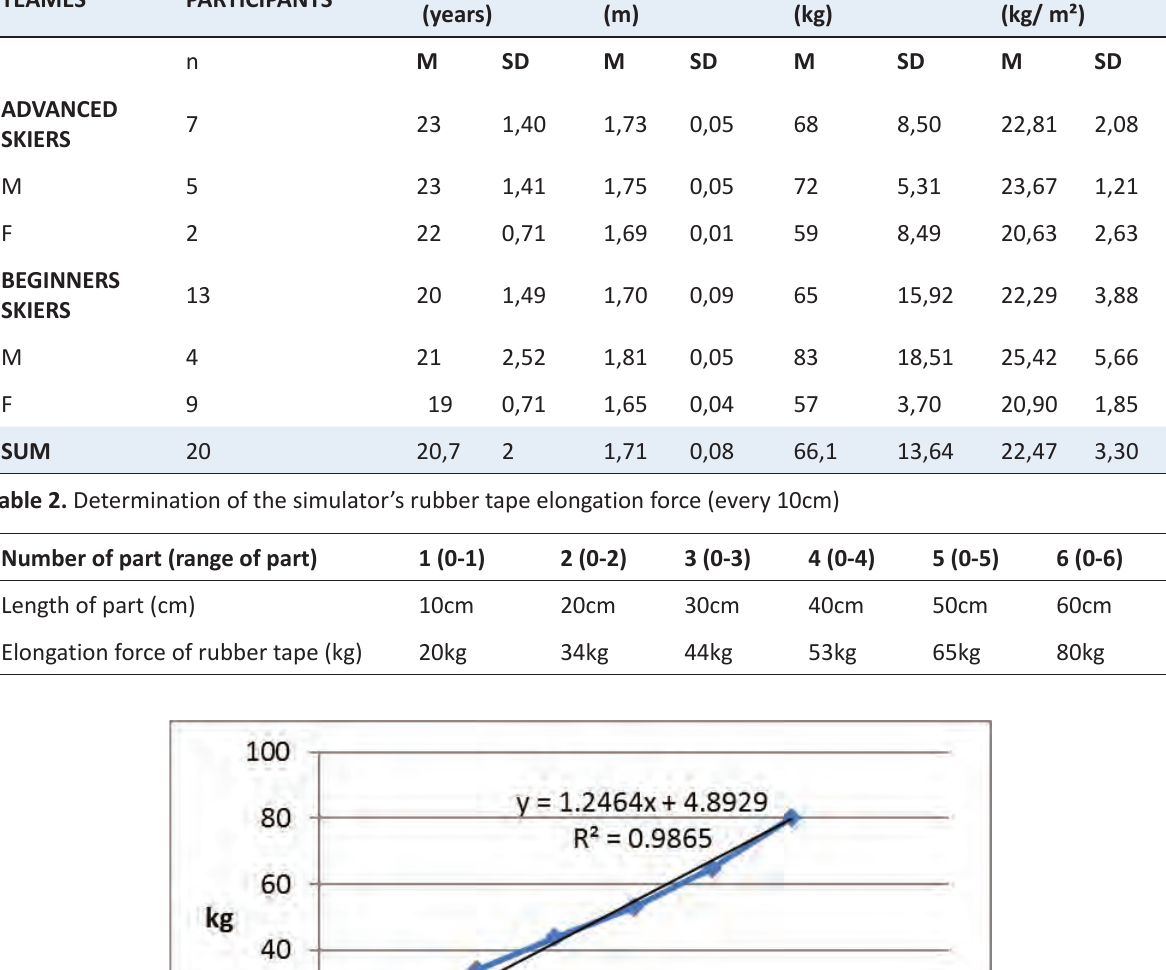
Table 1. The body features of the athletes taking part in the research TEAMES